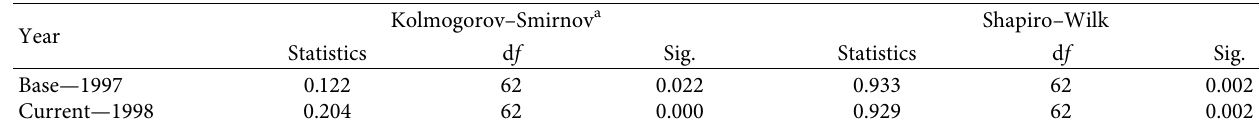
Table 13: Data normality test table.